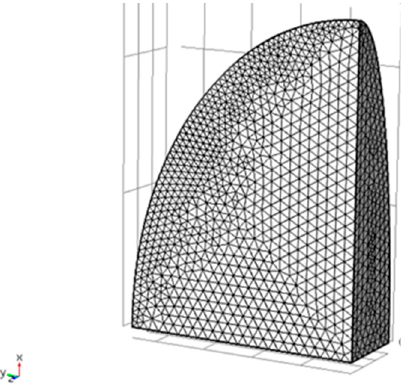
Figure 1. Finite element grid for a component of the stevia solid matrix.